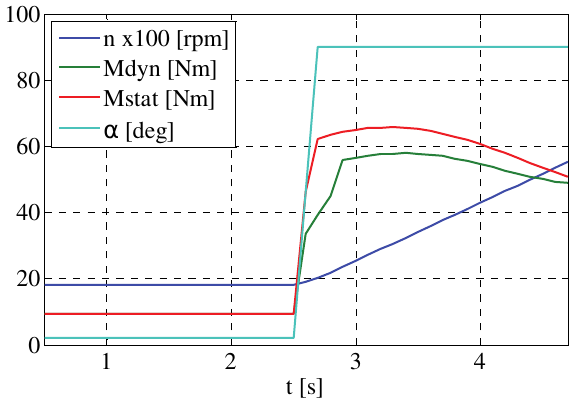
Fig. 8. Engine parameters in time of 2 seconds after full throttle opening